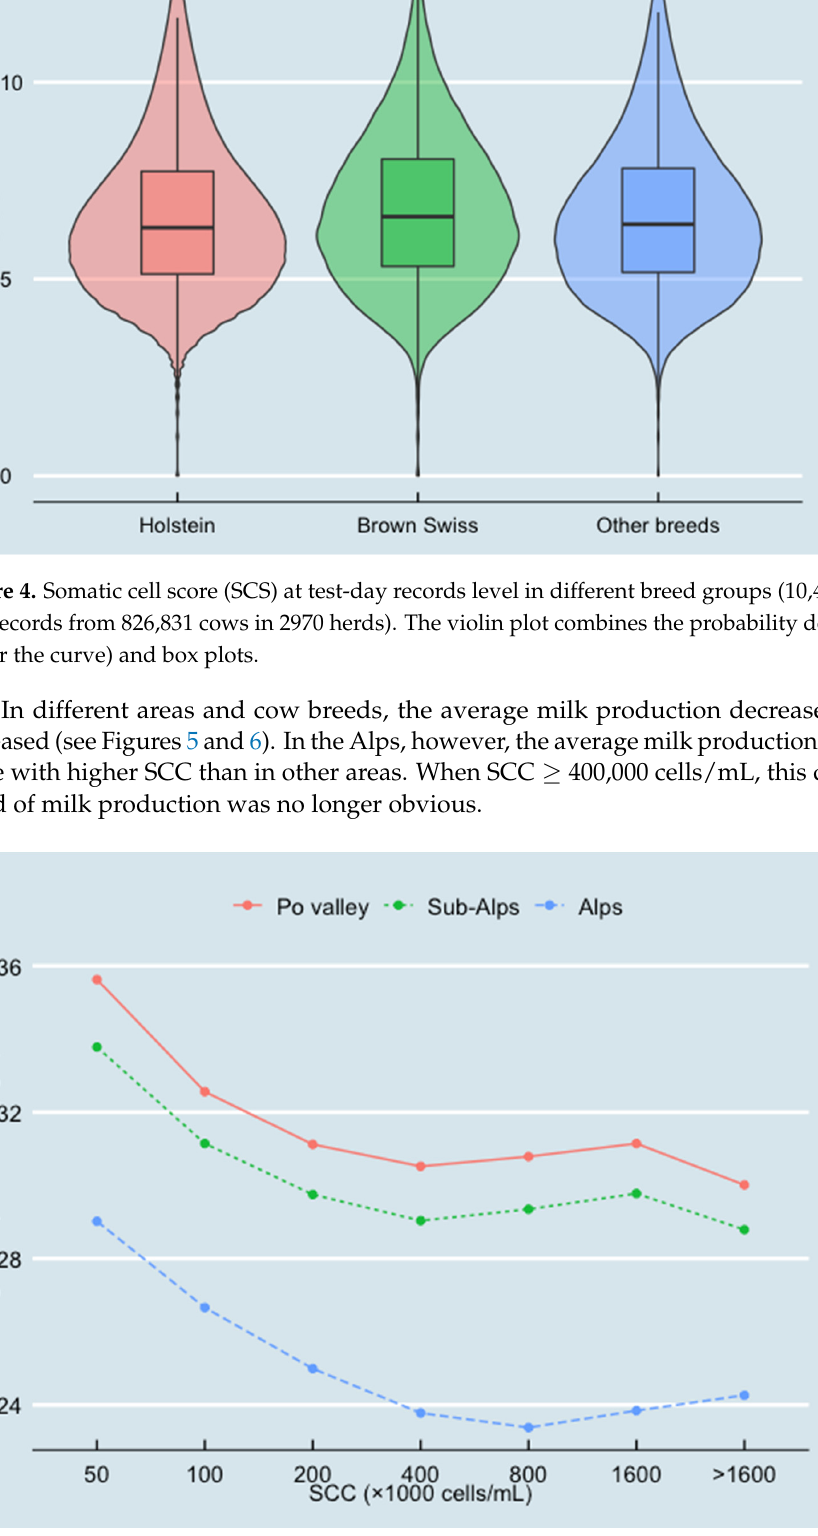
Figure 3. Somatic cell score (SCS) at test-day records level in different milk production quantile groups (10,445,464 test-day records from 826,831 cows on 2970 herds). The violin plot combines the probability density (area under the curve) and box plots.